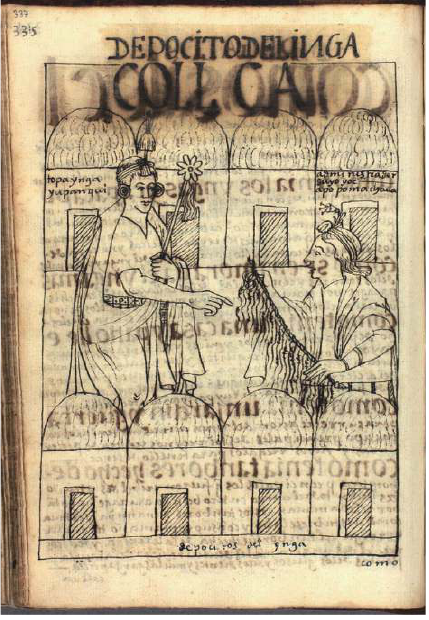
Fig. 2 Illustration by the Indigenous chronicler